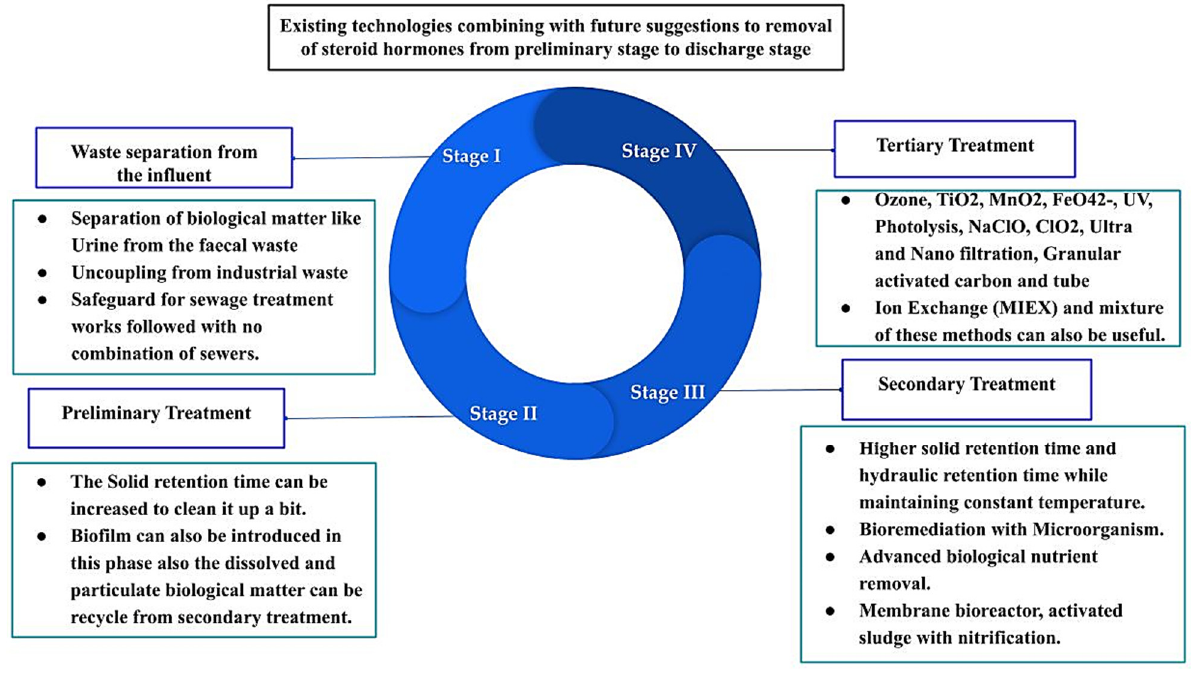
Figure 3. Existing technologies combined with future suggestions for removing steroids and hor- mones from the preliminary stage to the discharge stage of a wastewater treatment plant.